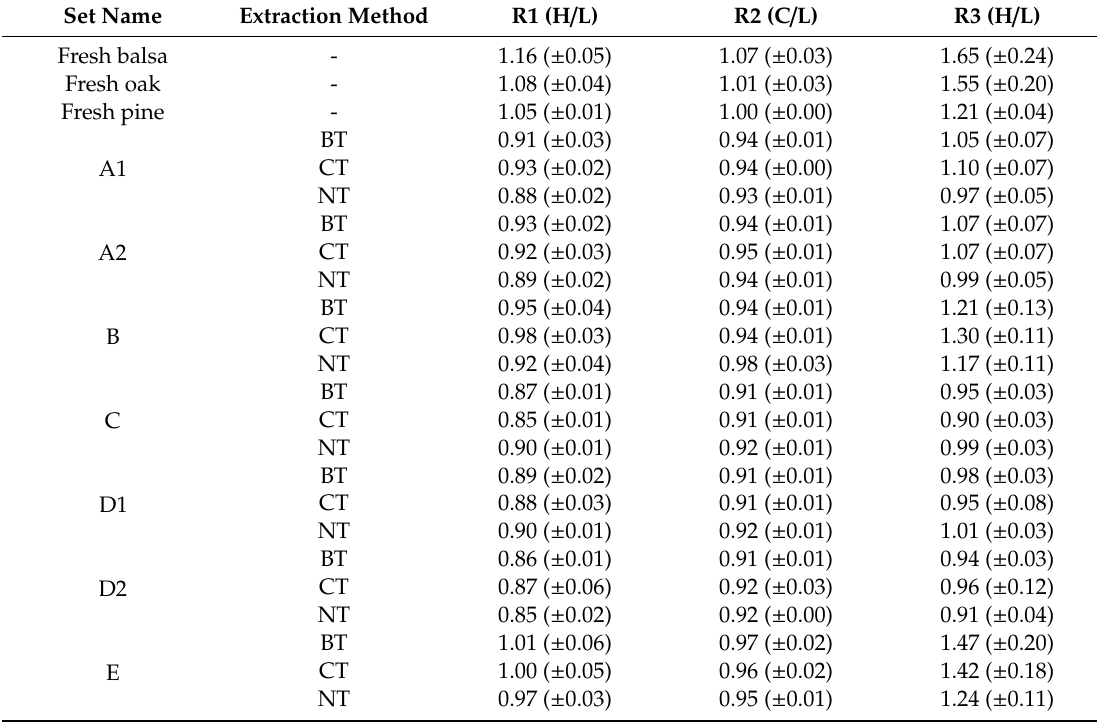
Table 2. ATR-FTIR ratios (R1 = I(1158) / I(1506), R2 = I(1374) / I(1506) and R3 = I(1034) / I(1506)) calculated for all sets compared with fresh balsa, oak and pine wood ( ± standard